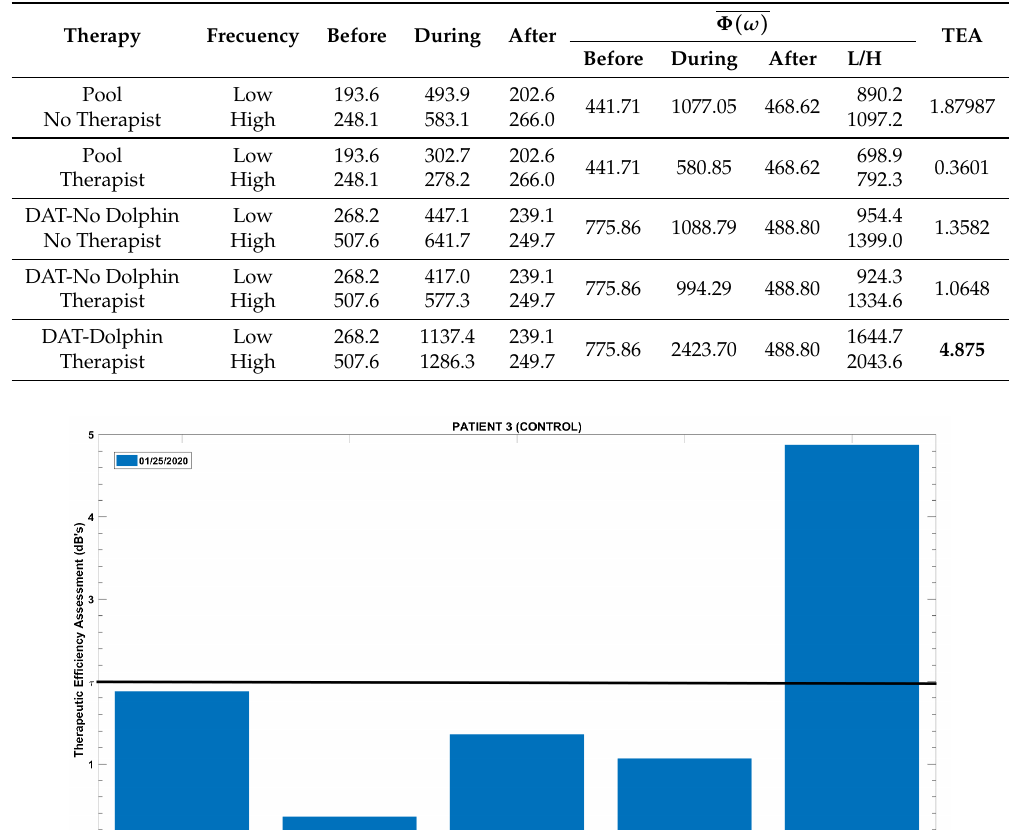
Table 3. Results of the Patient 3 (Control), On 01/25/2020 bold type indicates best TEA (dB).